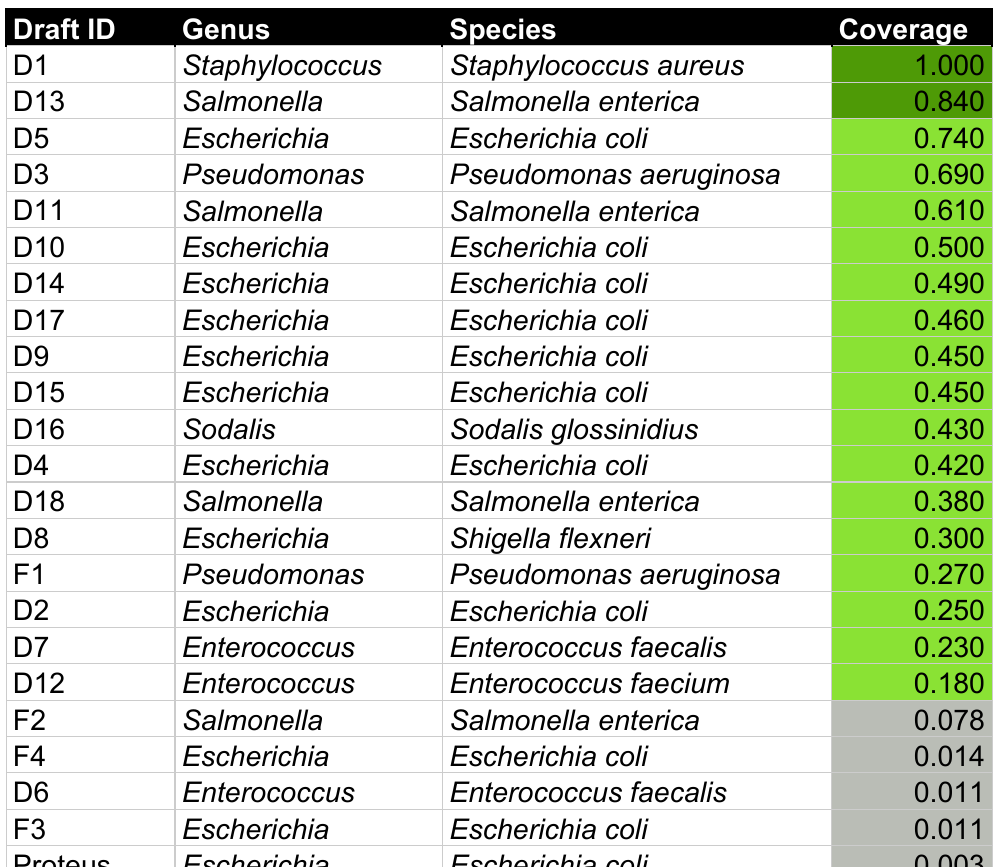
Table 5. Overview of the results of HostPhinder predicting the hosts of 19 phage draft genomes (name starts with a “D” and Proteus ) and 4 phage genome fragments (name starts with an “F”) from the INTESTI phage